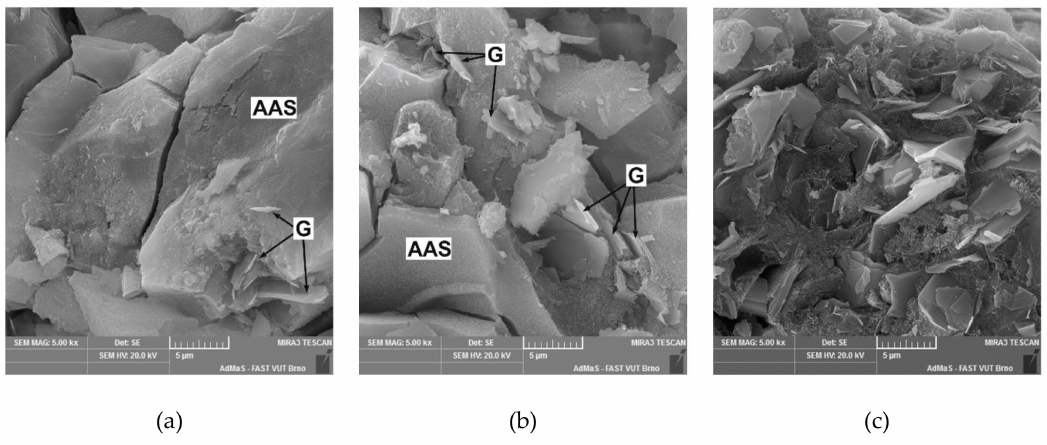
Figure 16. Microstructure of AAS composites with graphite filler—( a ) 5 wt% graphite; ( b ) 10 wt% graphite; ( c ) 30 wt% graphite (G—graphite